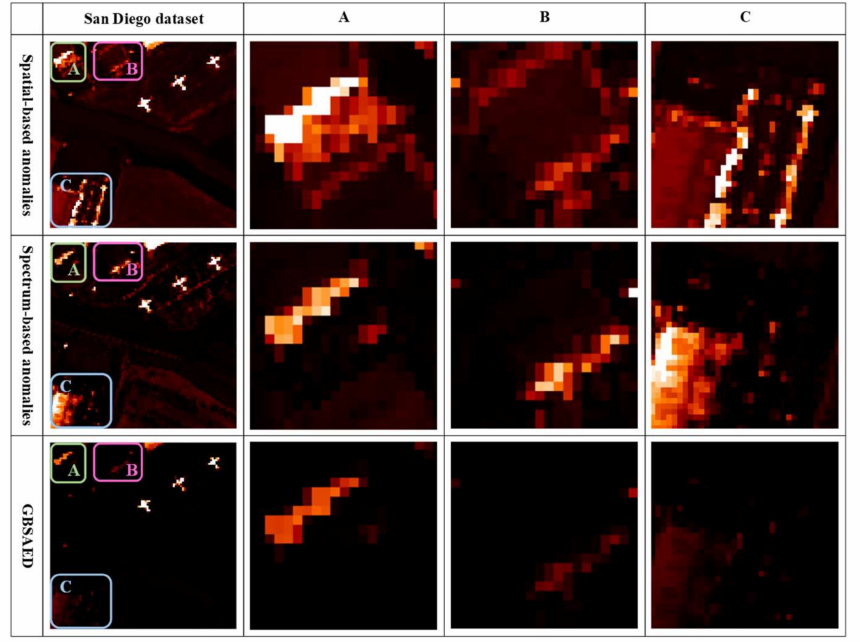
Figure 3. Detection details for spatial, spectral, and GBSAED methods. ( A ) Sparse background area A, ( B ) Sparse background area B, ( C ) Sparse background area